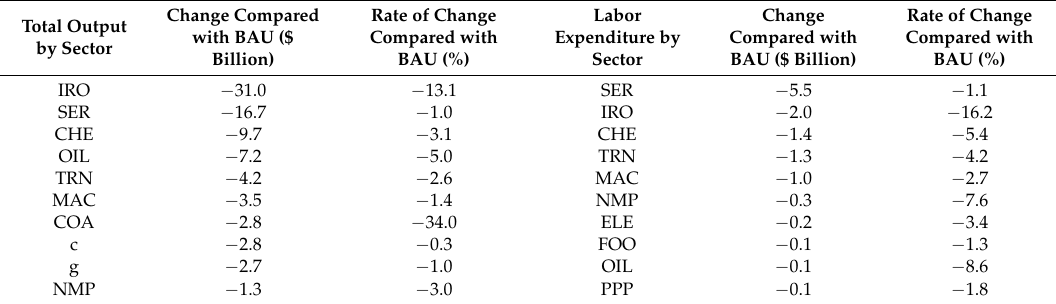
Table 9. GHG_22 scenario ripple effect by